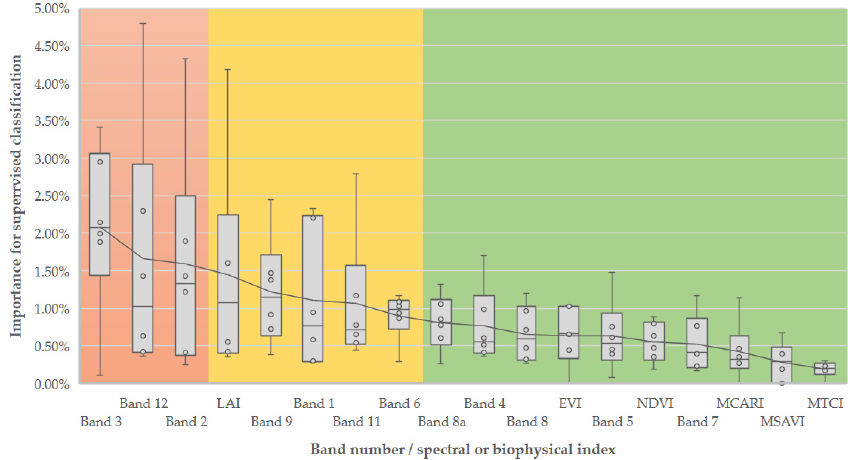
Figure 3. Boxplots showing the distribution of variable importance scores across classification algorithms and evaluation rounds sorted according to their average importance scores (each different background color represents approximately 33% of aggregated importance).